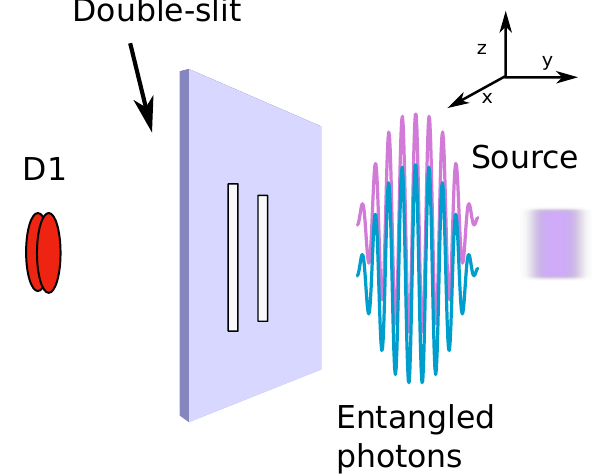
Figure 1: Schematic diagram for Young’s double-slit experi- ment with entangled photons. Detector D1 is capable of detect- ing pairs of photons. It should be able to discriminate between one-photon and two-photons